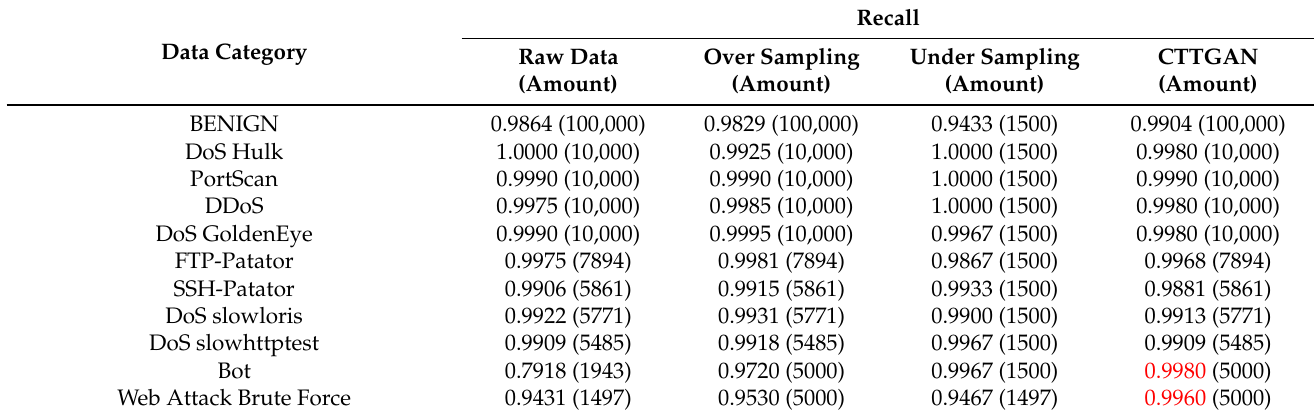
Table 6. Experimental results of the comparative